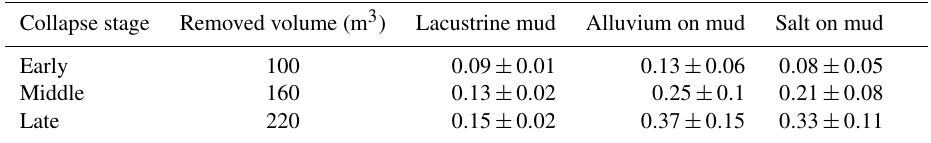
Figure 11. Evolution of maximum shear stress during cavity growth and sinkhole collapse in layered configurations of the end-member Dead Sea materials. Shown here are selected stages in the development of cavity/sinkhole in salty mud overlain by alluvium (a) , salty mud overlain by rock salt (b) and rock salt overlain by salty mud (c) . The same model setups as in Fig. 10 are used. Table 6. Depth / diameter ratios for modelled sinkhole collapses. A set of five models for each material combination is analysed for a subrosion zone at middle depth (30m). De / Di ratios for alluvium and salt are generally higher than for